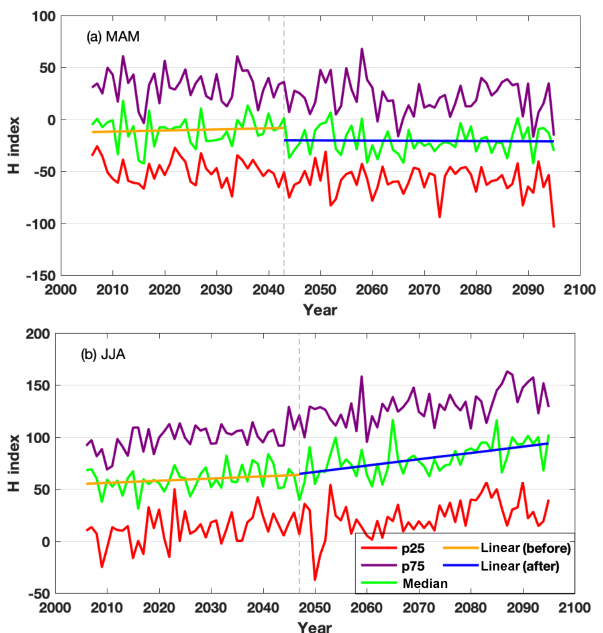
Figure 6. H index for (a) the spring (MAM) anomalous low and (b) summer (JJA) anomalous high centered over the northwest- ern USA during the 21st century projected from CMIP5 ensemble model information. The lines indicate the median, 25th percentile, and 75th percentile. Also shown are piecewise linear regression lines separated at the “break” year indicated by the dashed line. As- sessments using the Mann–Kendall method (Kendall, 1955) show that only the after break trend for JJA is significant at the 5% level. The before and after break trends are significantly different at 5% for JJA